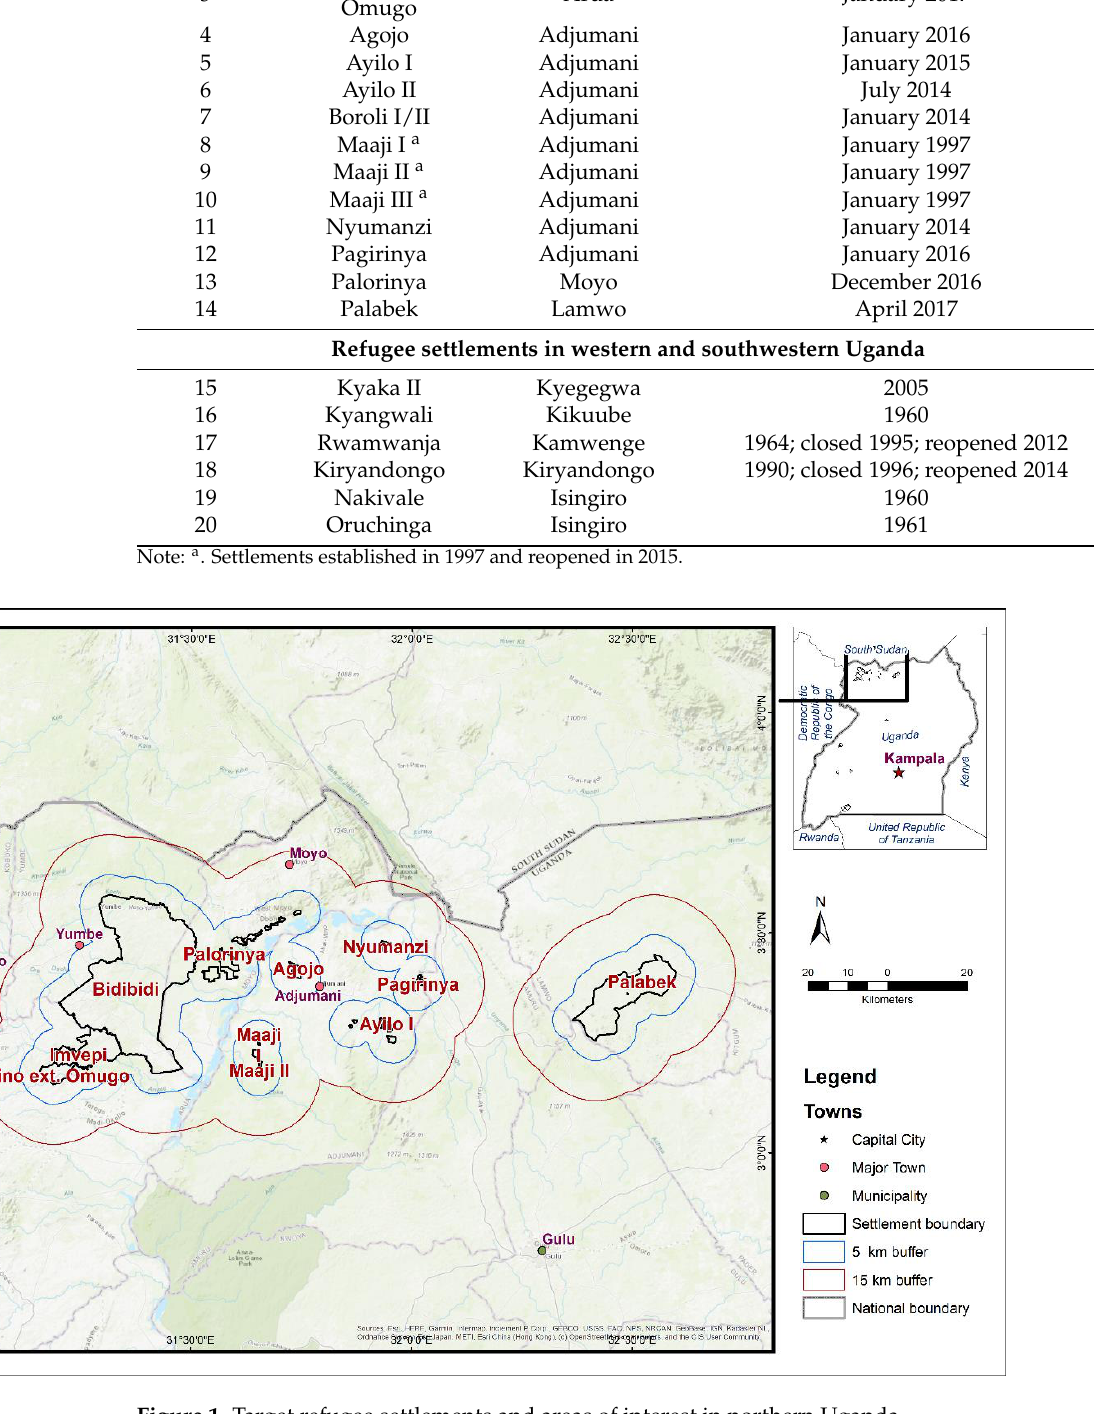
Figure 1. Target refugee settlements and areas of interest in northern Uganda.